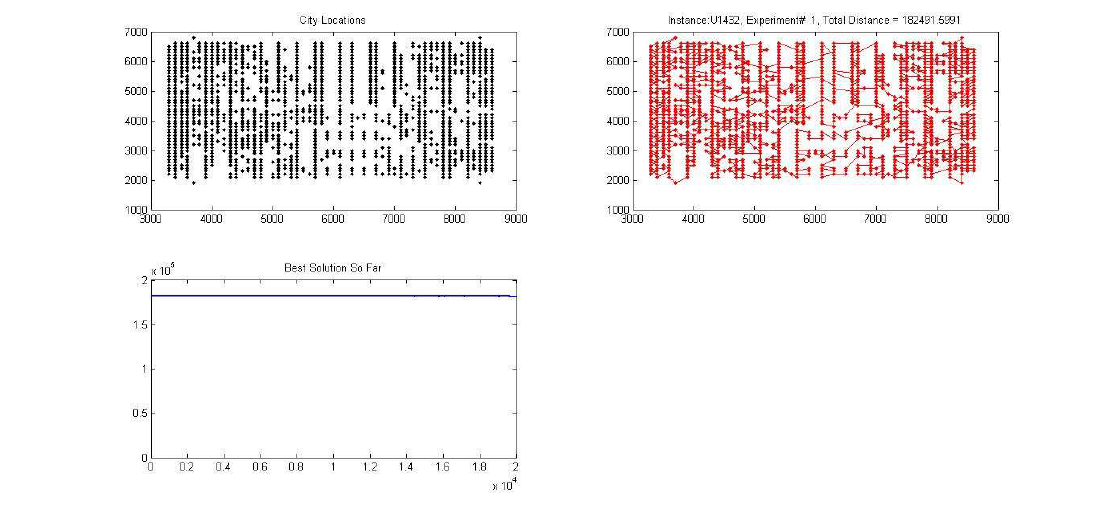
Figure 5. Graph illustrating one of the experiments on the U1432 instance of TSP (containing 1432 cities) solved by the proposed BCSO algorithm. The graph depicts the city location, total distance and best solution